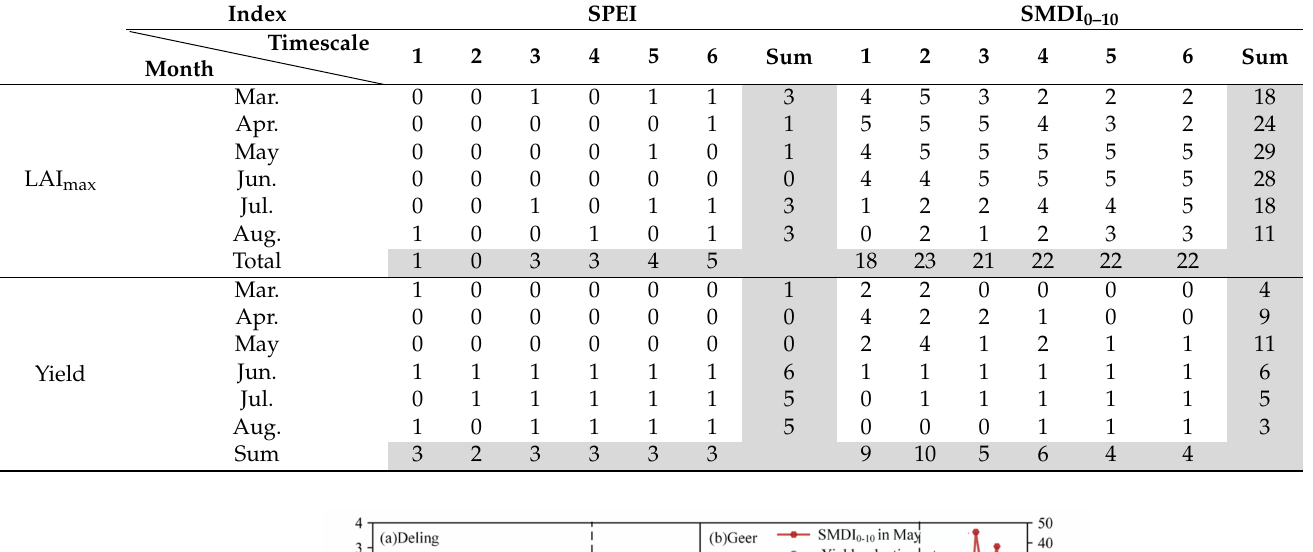
though after 2000, the drought was relieved and tended to be wetter, the yield did not increase accordingly. Table 5. The number of stations with r > 0.21 between pairs of spring wheat growth indices (LAImax or climatic yields) and drought indices (SPEI and SMDI0–10 at the 1- to 6-month timescales) over 1961–2018. (The sum of the unconditional counts for each row or column is 48). Growth index. SMDI 0–10